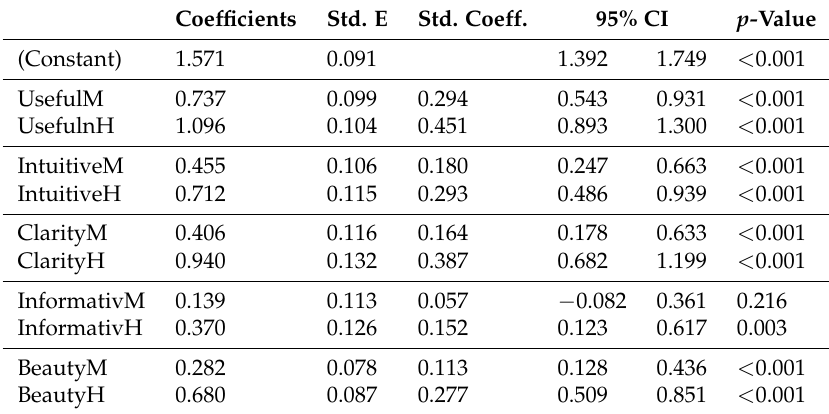
Table 1. Linear-regression analysis with a dichotomized version of the items to verify the proportionality of ordinal items with numerical